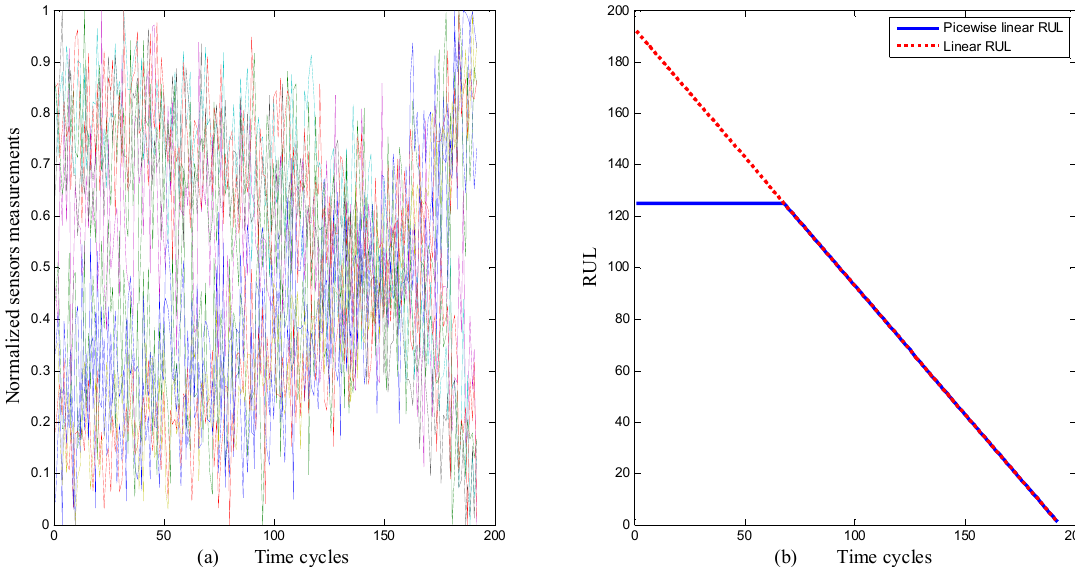
Figure 1. ( a ) Normalized sensors measurement. ( b ) Corresponding RUL to sensors measurement.